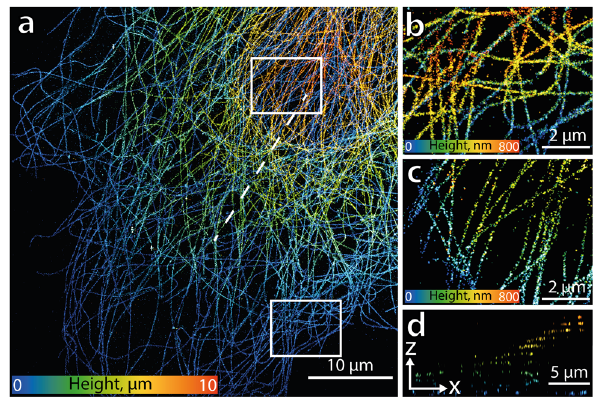
Figure 4: Multiplane astigmatism-based single-molecule localization microscopy. (a) A height coded render of tubulin in a COS-7 cell immunostained with Abberior FLIP-565 self-blinking dye imaged by adding 60 nm RMS of astigmatism. (b – c) Zoom-ins from the bottom (b) and top (c) planes of the full image stack (d) A slice marked in (a) with a dashed line showing the axial profile of the whole volume consisting of 10 sub-volumes spaced with 1 μ m